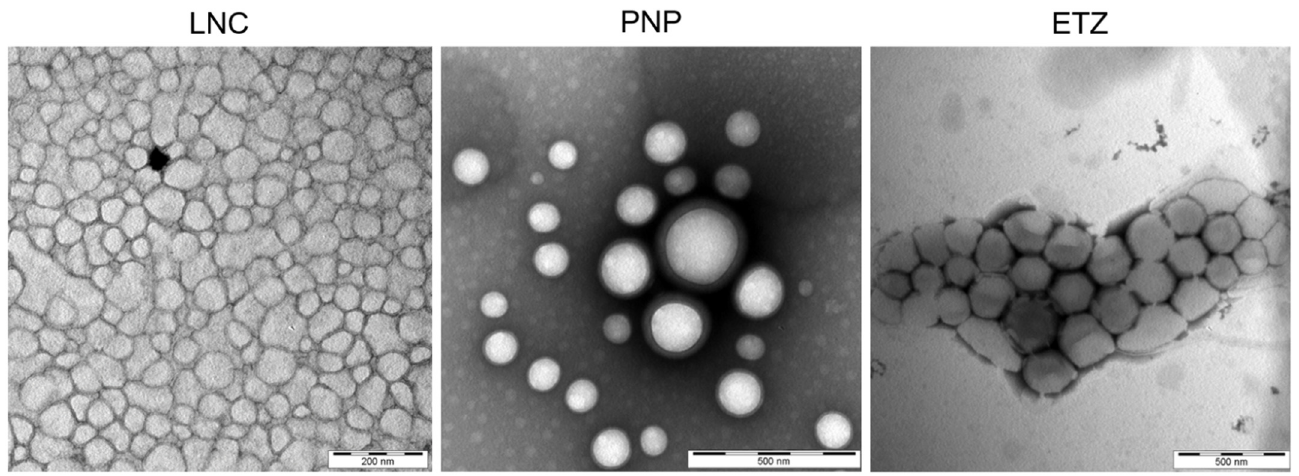
Figure 3. Transmission electron microscopy of HC loaded-nanosystems studied in this work: lipid nanocapsules (LNC), polymeric nanoparticles (PNP) and ethosomes (ETZ).